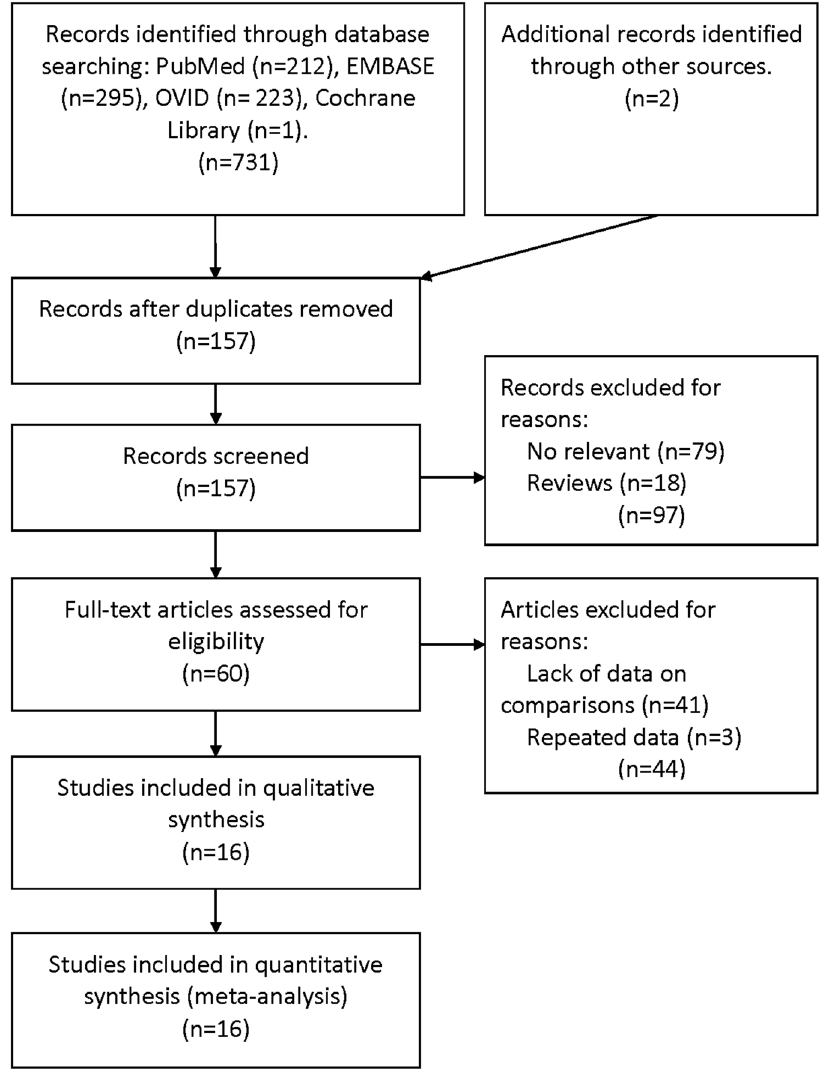
Figure 1. Flowchart of the identification of relevant